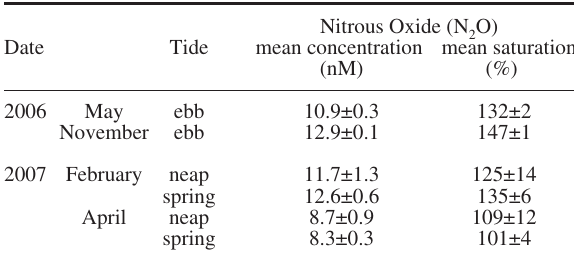
T able 2. – Mean N O concentrations and percent saturation (± 2 standard deviation, SD) along the Tagus estuary (May and Novem-